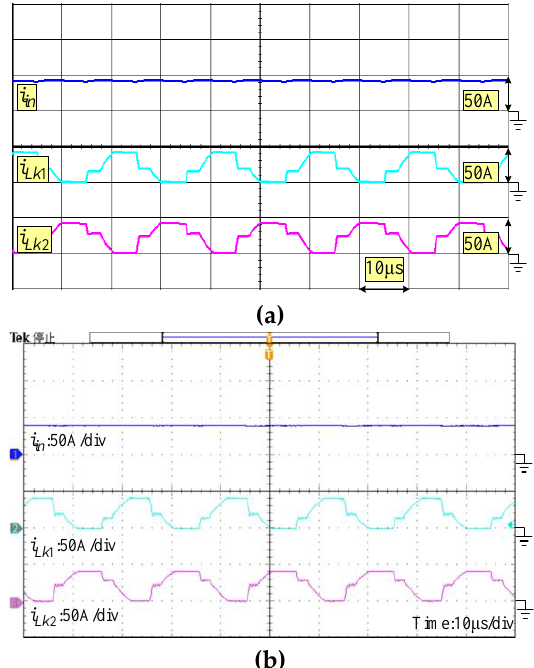
Figure 14. Waveforms of i in , i Lk 1 and i Lk 2 . ( a ) Simulated results. ( b ) Experimental results.